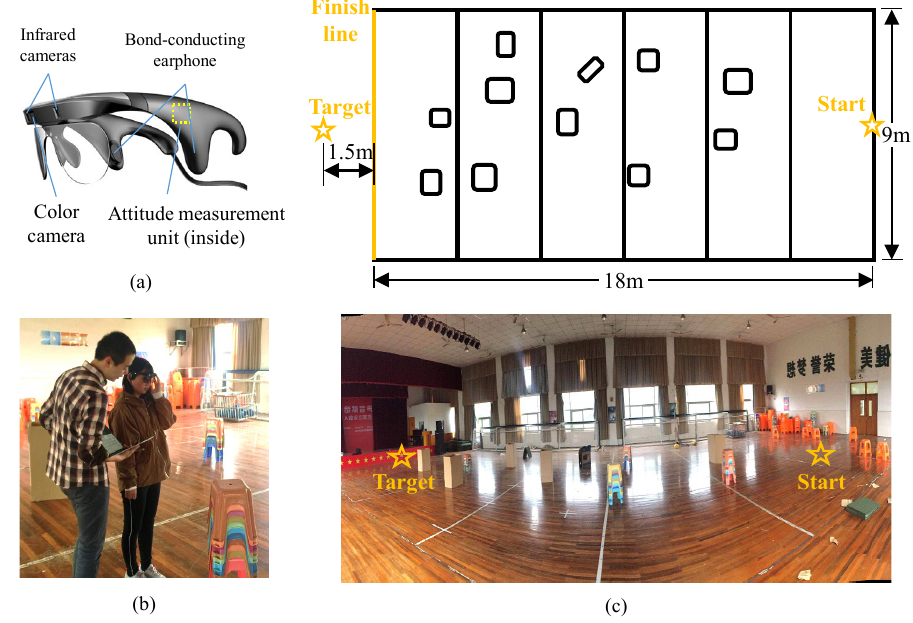
Figure 6. Field experiments. ( a ) Hardware implementation. A pair of smart glasses with an RGB-D camera and a bone conduction headphone. ( b ) A participant is training in the field with the help of us. ( c ) Diagram and panorama image of the experiment field, where obstacles are represented by little